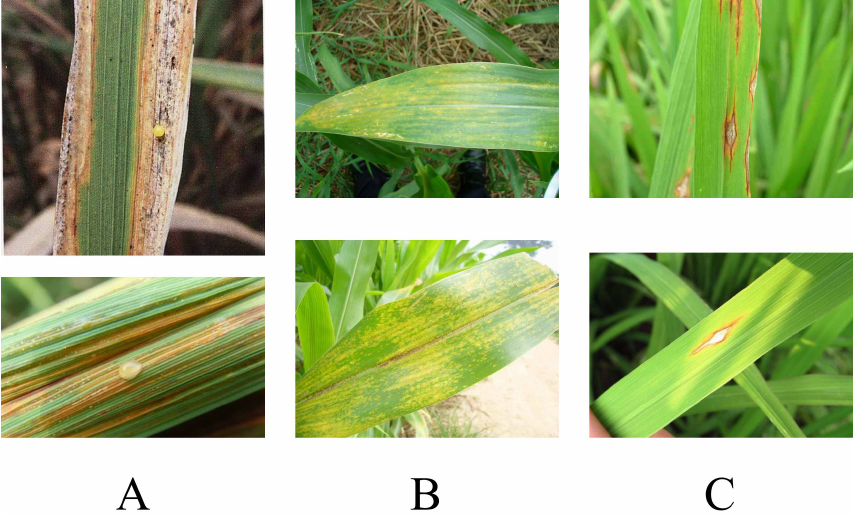
Figure 1. The three main diseases mentioned in [30]. ( A ) is Bacterial Leaf Blight. It is a disease that occurs in rice and is caused by the bacterium Leucaena leucocephala. The disease affects leaves and can also infect leaf sheaths. It is a phytosanitary target in China. ( B ) is Brown Spot.It is a fungal disease caused mainly by the fungus Bacillus subtilis. ( C ) is Leaf Blast. Rice blast occurs throughout the rice reproductive period and can be classified into seedling blast, leaf blast, node blast, spike blast and grain blast depending on the period and location of damage. Leaf plague can occur throughout the entire reproductive period, and the damage is heavier from tillering to nodulation. Leaf plague directly affects the normal growth of rice, and in severe cases, the plant will die, leading to a reduction in rice production or even a crop